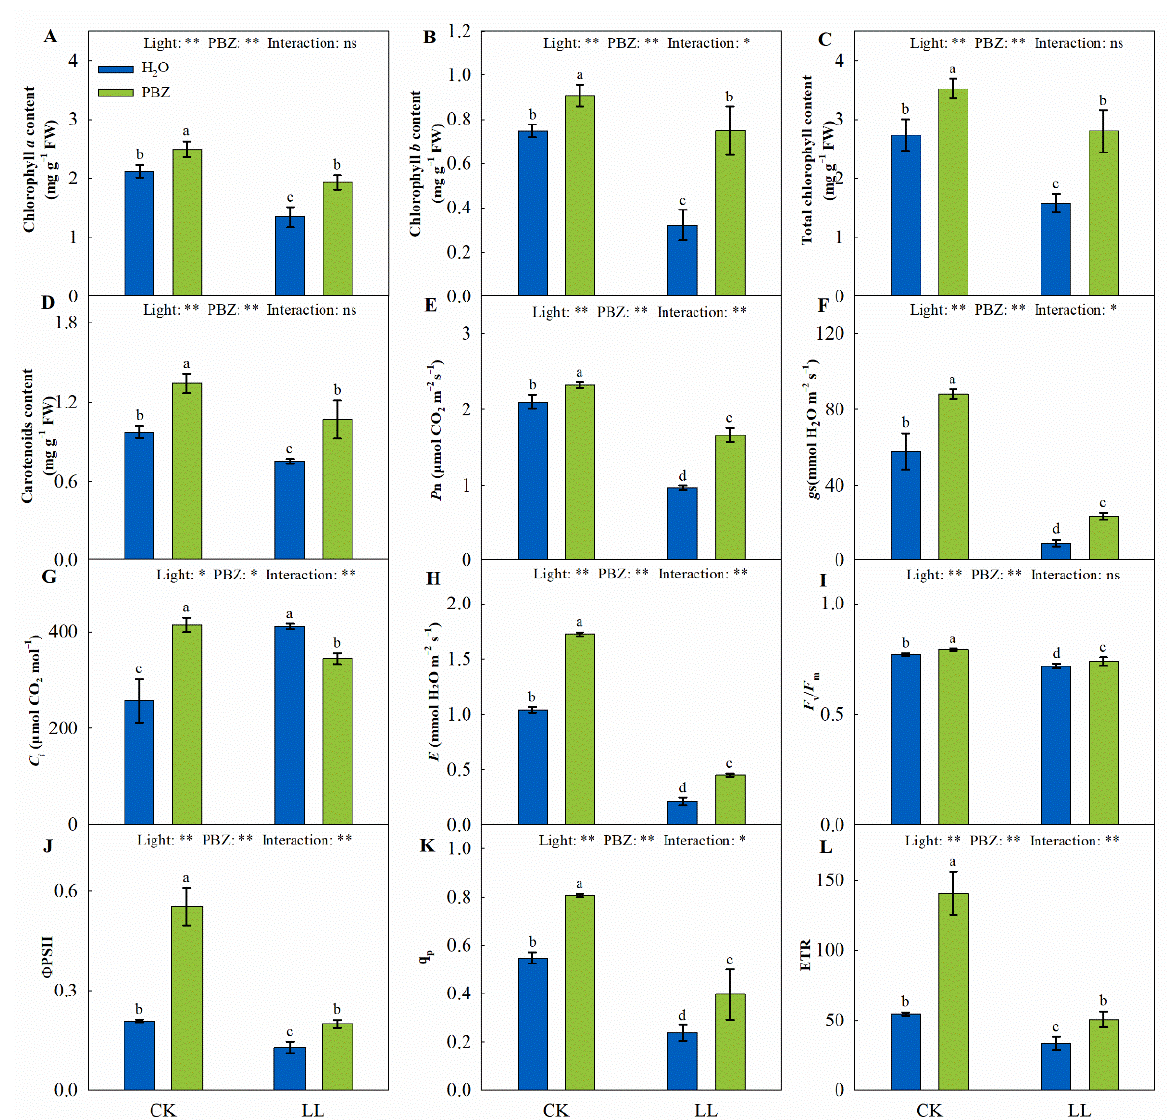
Figure 2. Levels of chlorophyll a content ( A ), chlorophyll b content ( B ), total chlorophyll content ( C ), carotenoids content ( D ), net photosynthetic rate ( P n , ( E )), stomatal conductance ( g s, ( F )), intercellular CO 2 concentration ( C i , G ), transpiration rate ( E , ( H )), maximum quantum yield of photosystem II (PSII) photochemistry ( F v / F m , ( I )), actual quantum yield of PSII photochemistry ( Φ PSII, ( J )), photochemical quenching coefficient (q p , ( K )), and relative electron transport rate (ETR, ( L )) of tall fescue leaves induced by paclobutrazol under control (CK) and LL stress. * and ** indicate significant differences at p < 0.05 and p < 0.01, respectively. ns indicates not significant. Different letters above the vertical bars indicate significant differences at p < 0.05 according to Duncan’s multiple range test.